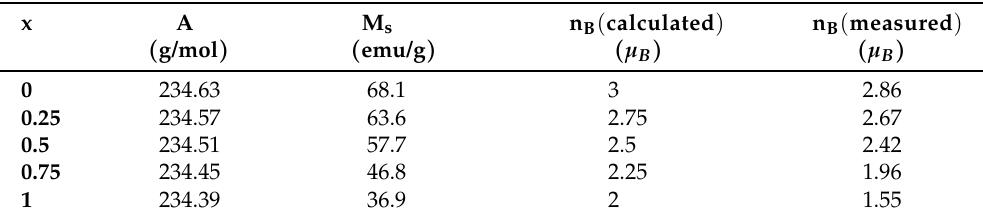
Table 4. Molecular weight ( A ), RT saturation magnetization ( M s ), calculated net magnetic moment n B ( Calculated ) , and measured net magnetic moment n B ( Measured ) of the Ni x Co 1 − x Fe 2 O 4 ferrites with 0 ≤ x ≤ 1.